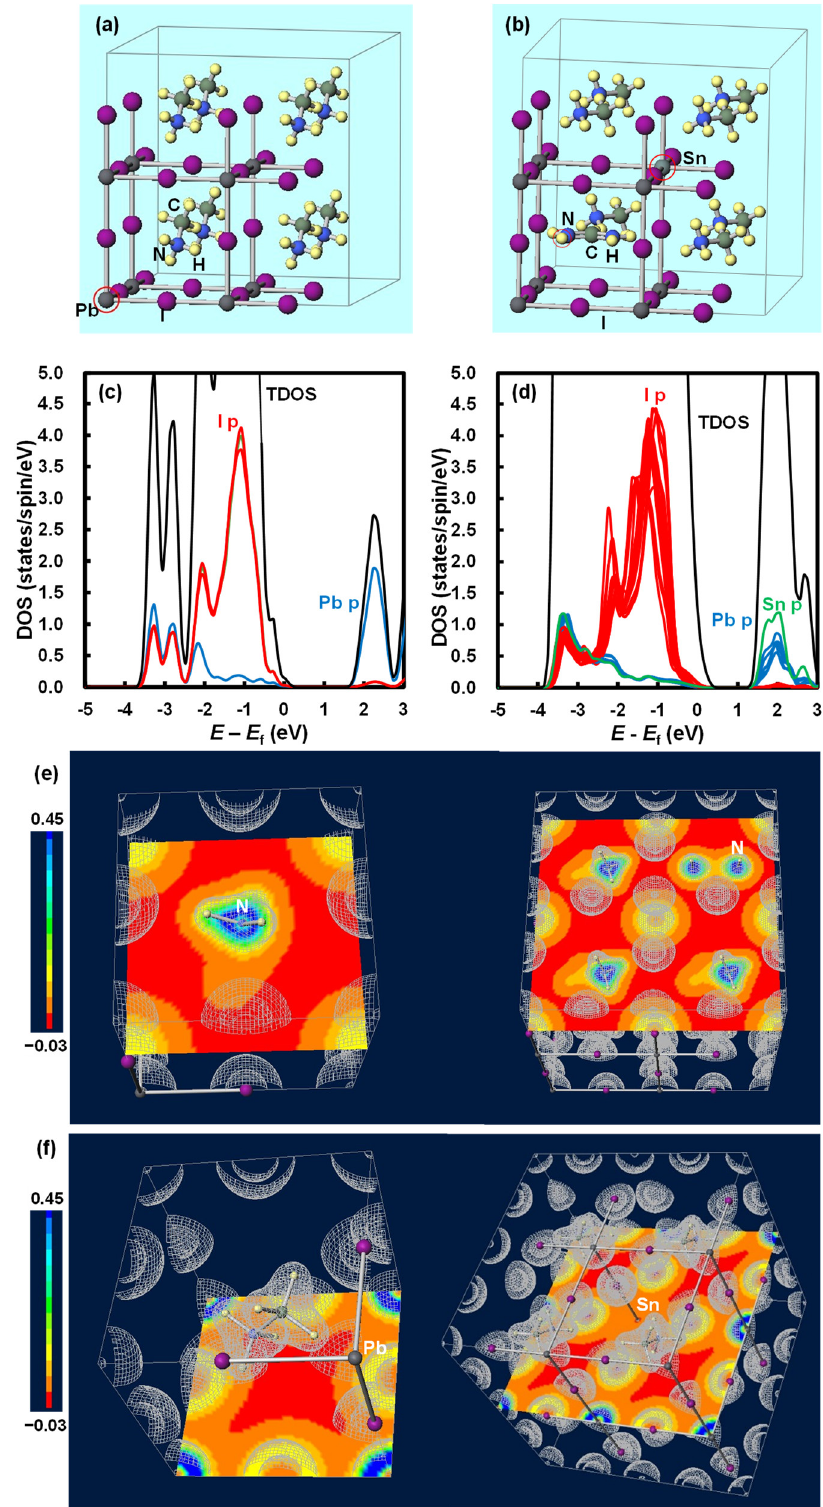
Figure 8. Crystal structures of ( a ) MAPbI 3 and ( b ) MA(FA)Pb(Sn)I 3 , ( c ) partial density of state of MAPbI 3 , ( d ) partial density of state of MA(FA)Pb(Sn)I 3 , electron density distribution of ( e ) MAPbI 3 , and ( f ) MA(FA)Pb(Sn)I 3 . Calculation results of electron density distribution for the MAPbI 3 and MA(FA)Pb(Sn)I 3 are shown in Figure 8e,f, respectively. Positions of nitrogen (N) are indi- cated in Figure 8e. The electron density distribution of I was widened, and the electrons